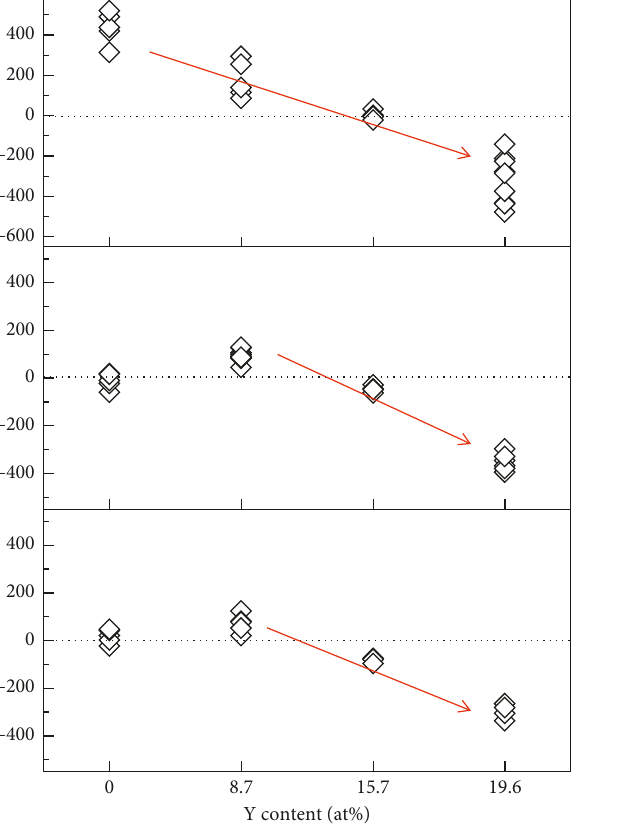
Figure 7: CuMn film TCR temperature dependence with various yttrium contents annealed at different